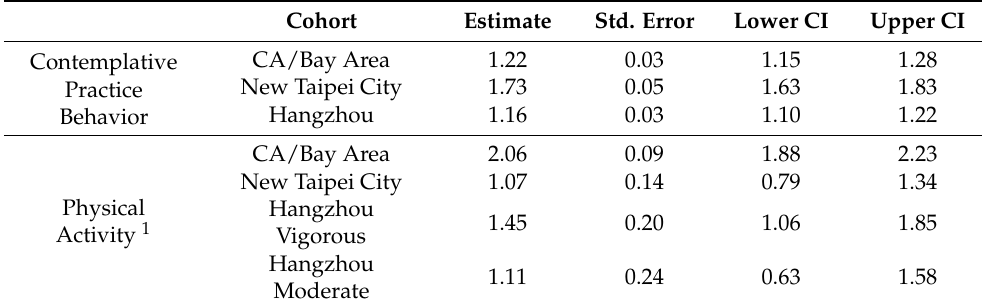
Figure 1. Associations between overall WELL scores, contemplative practice behavior, and physical activity. Note: A different physical activity measure was used for the Hangzhou cohort (International Physical Activity Questionnaire; categorical variable with PA-Low as reference group) than for the CA/Bay Area and New Taipei City cohorts (L-Cat 2.2; ordinal variable, 1–6). Table 4. Regression coefficient estimates for CPB and PA in the models for the overall WELL score. Cohort Estimate Std. Error Lower CI Upper